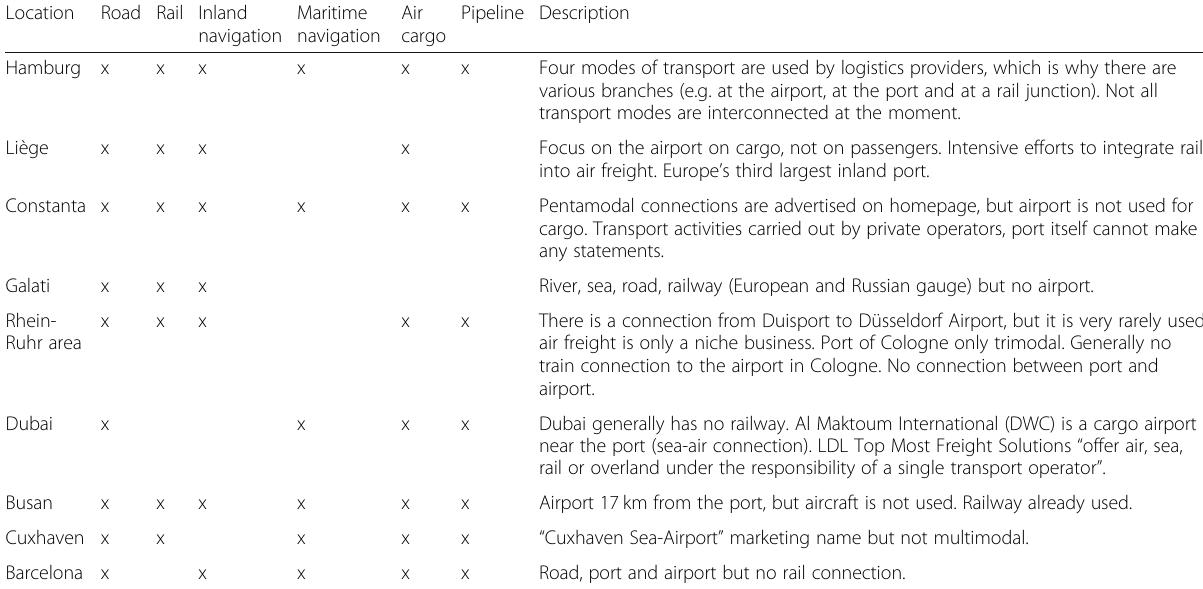
Table 1 Site visits